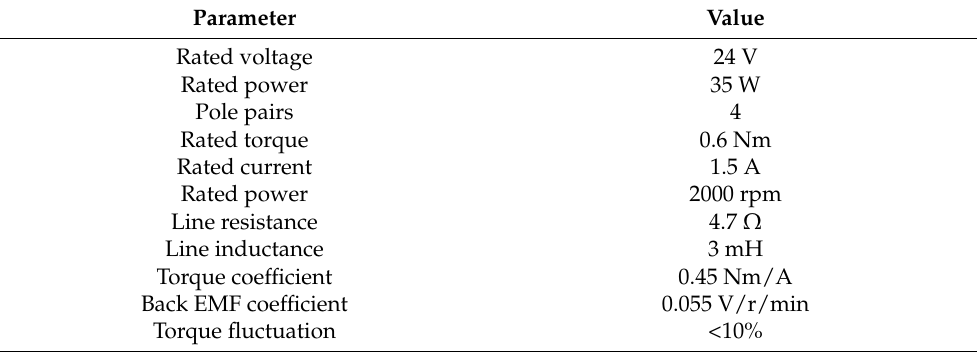
Figure 12. Experimental platform. Table 2. Motor parameters.